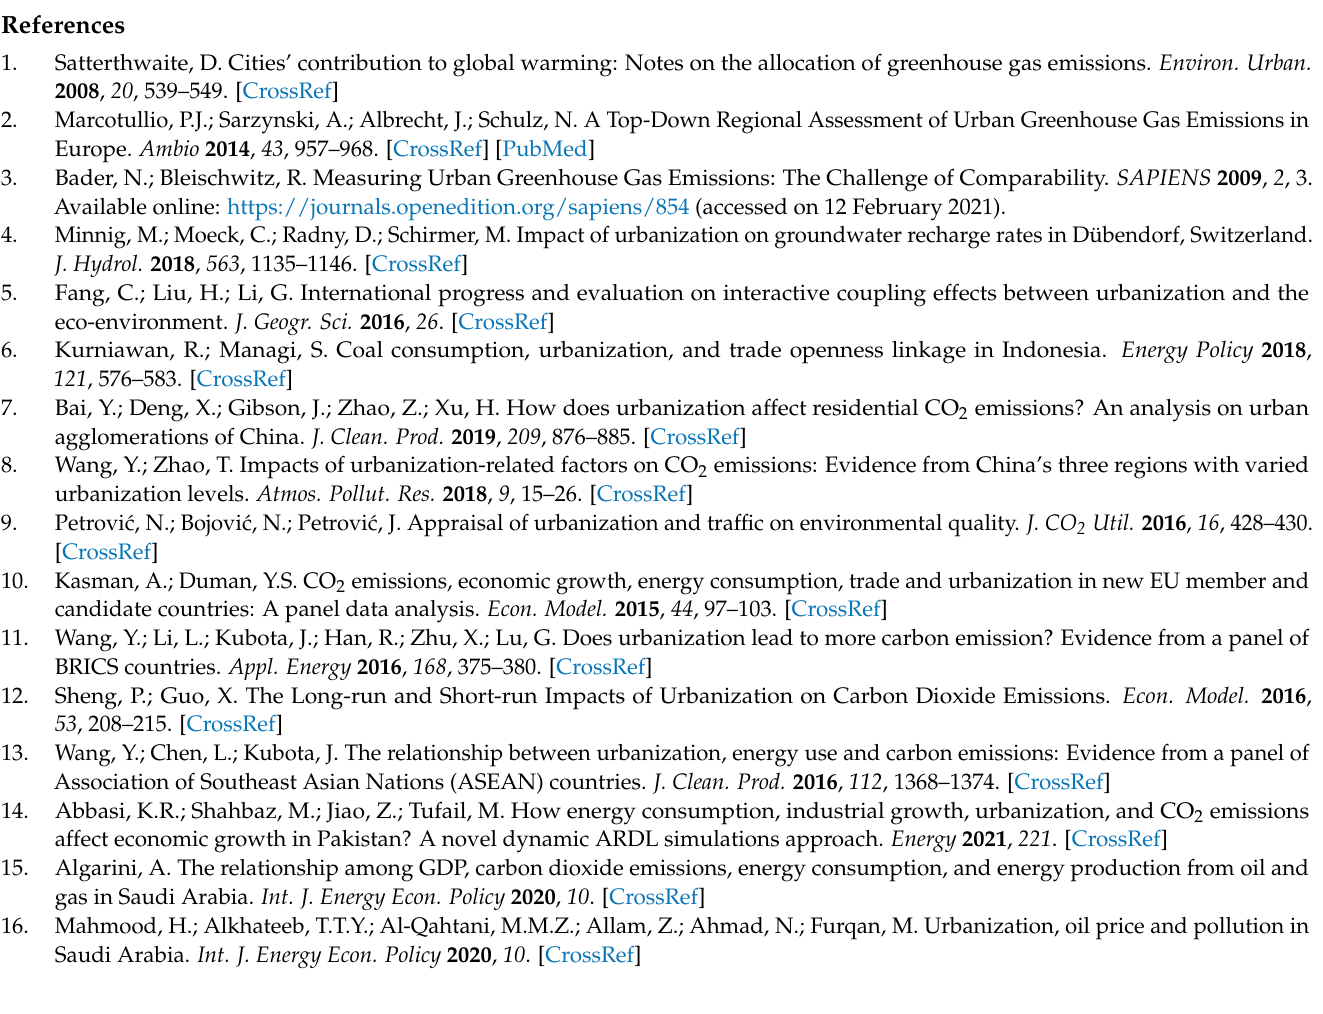
Figure A1. Energy Total Production and CO 2 emissions—Country Clusters (Poland